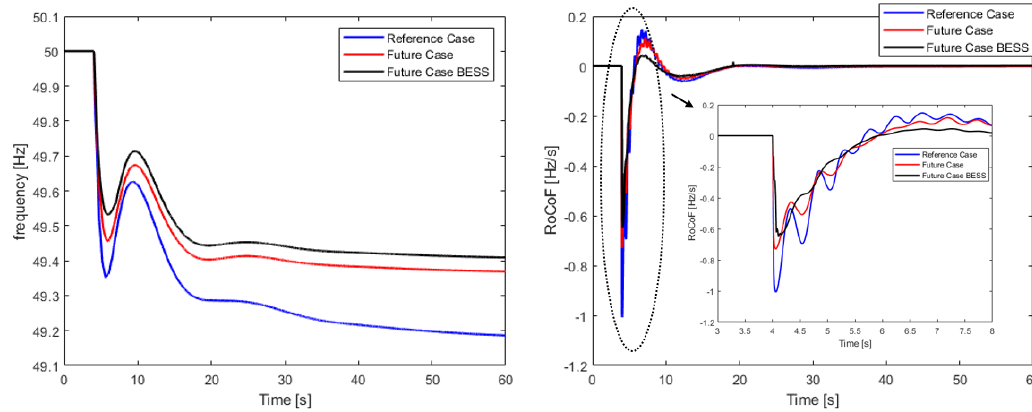
Figure 14. Generation loss frequency response and RoCoF for the best cases of the reference, future and future with BESS scenarios.